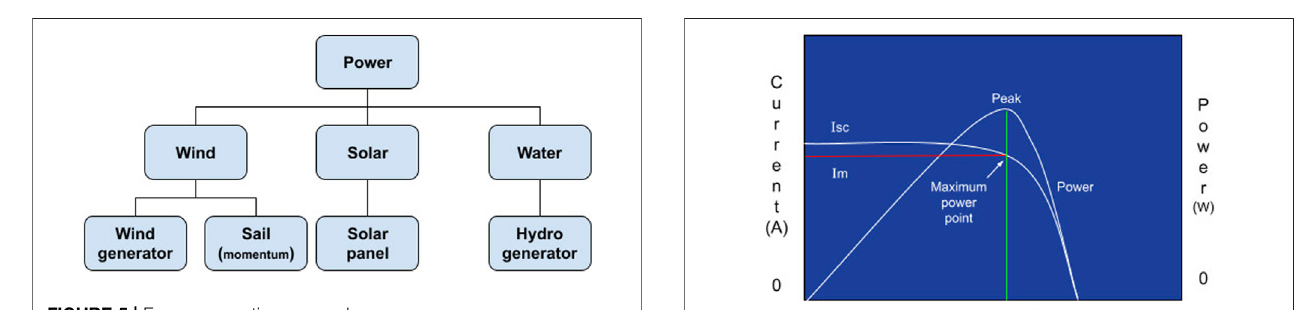
FIGURE 5 | Energy generation approaches.